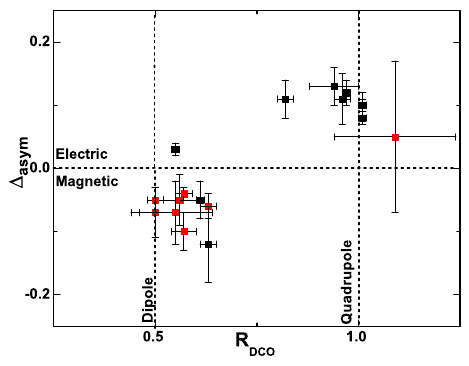
Figure 2. The DCO ratio (R DCO ) [17] vs the polarization asym- metry ( ∆ as y m ) [18] of the new γ rays (in red) reported in this work and that of the known γ -rays (in black). The DCO ratios are ob- tained in quadrupole gates. The dotted lines parallel to the Y-axis at 0.5 and 1.0 correspond to the DCO ratio of pure dipole and quadrupole transitions respectively. The dotted line parallel to the X-axis is to guide the eye for ∆ as y m values corresponding to the electric ( + ve) and magnetic (-ve) nature of the transitions.